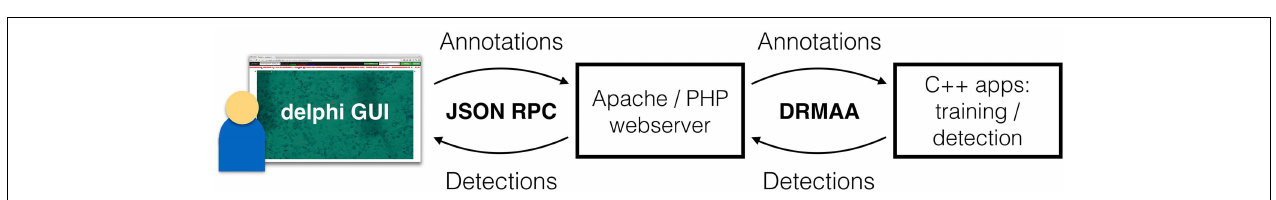
for a whole transect possible in < 5 min. The field expert can poll for the results, which are transferred back to the DELPHI GUI through JSON RPC when the detection is completed. The web interface is then updated based on the results. A further iteration of LP annotation/correction with subsequent training and detection can follow if the detection result is seen as